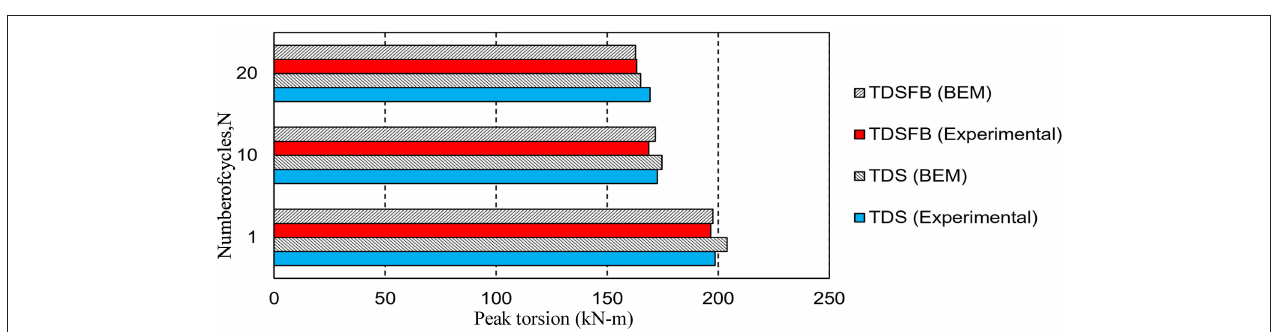
FIGURE 4 | Comparison of the results computed using BEM with Guo and Randolph (1996).